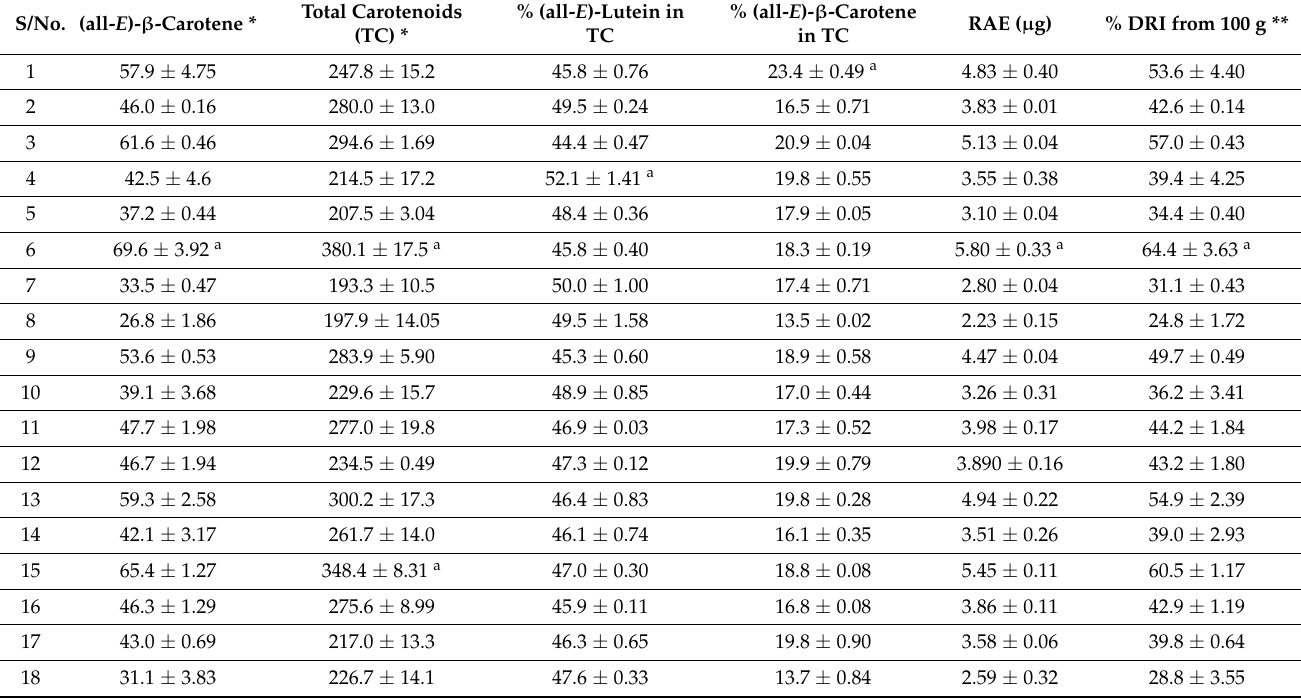
Table 4. The (all- E )- β -carotene, total carotenoids, and retinol activity equivalents (RAEs) in studied traditional